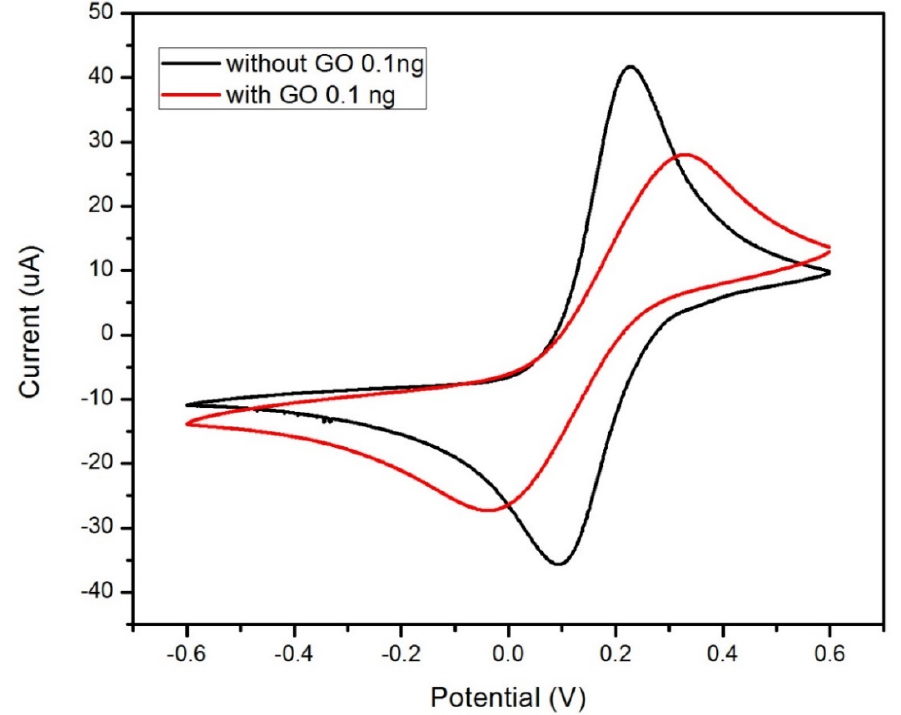
Figure 5. Electrochemical current responses from cyclic voltammetry testing on the cortisol biosensor made with and without 0.1 ng graphene oxide on the working electrode. A potential range of ± 0.6 V was used with K 4 FeCN 6 in PBS as the redox moiety at a scan rate of 50 mV/s.